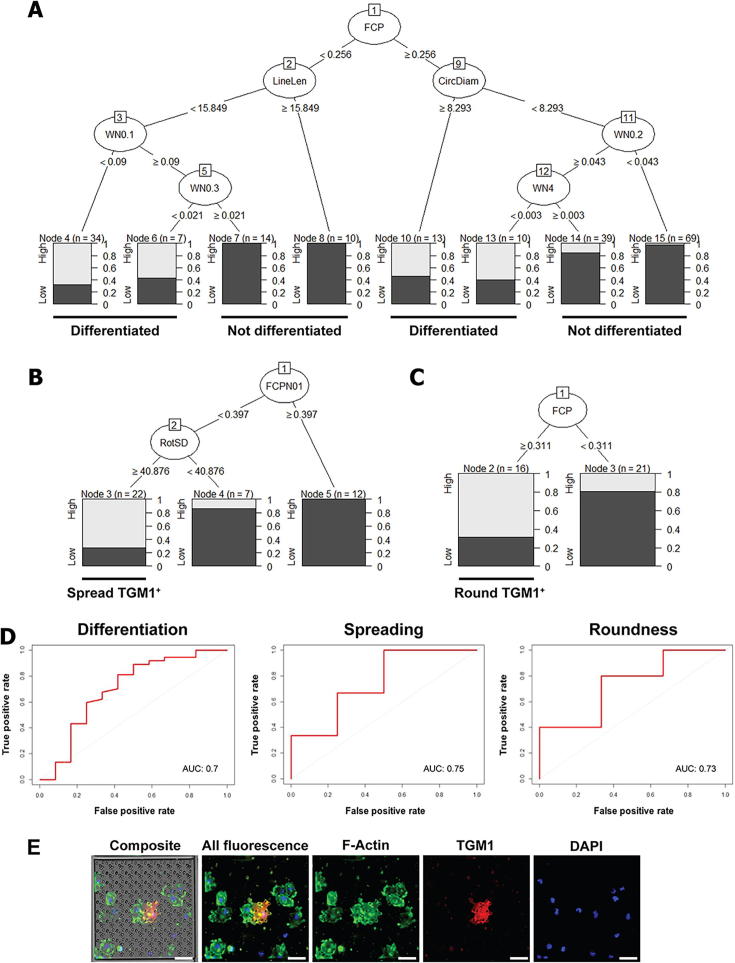
Computational models to predict the differentiation of keratinocytes. A-C) Classification trees showing the proportions of TopoUnits with A) differentiated cells, B) spread differentiated cells (above the top threshold in Fig. 2E) and C) differntiated cells that are round (cells above the top threshold in Fig. 2F), when separating for topographical parameters (described in File S1). D) ROC curves and AUCs for the models shown in A-C). Results are based on five independent experiments. Hits were ranked and selected per individual experiment. Light grey (and the annotation ‘high’) represents TopoUnits that were top hits from experiments. Dark grey (and the annotation ‘low’) represents bottom hits. FCP: proportion of pixels covered by topographies, LineLen: line length, CircDiam: circle diameter, WNx: the fraction of energy in the signal with wavenumber X, FCNP01: FCP with computationally added variation to account for more potential experimental variation, RotSD: standard deviation of the angle under which topography primitives are placed within the topography feature; a measure of topography irregularity (also see File S1). AUC: area under the curve. E) A TopoUnit surface that was a top hit in B (FCPN01: 0.0989901, RotSD: 162.428) and a bottom hit in C (FCP: 0.152628). Images show a differentiated cell that was highly spread. Scale bars in E represent 50 µm.